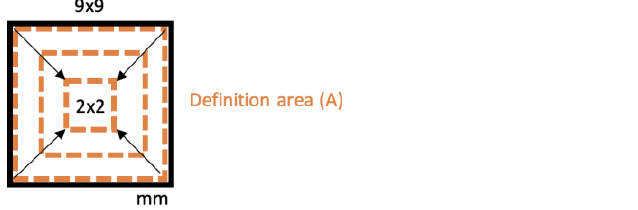
Figure 4. Definition area ( A ) evaluation: influence of boundary